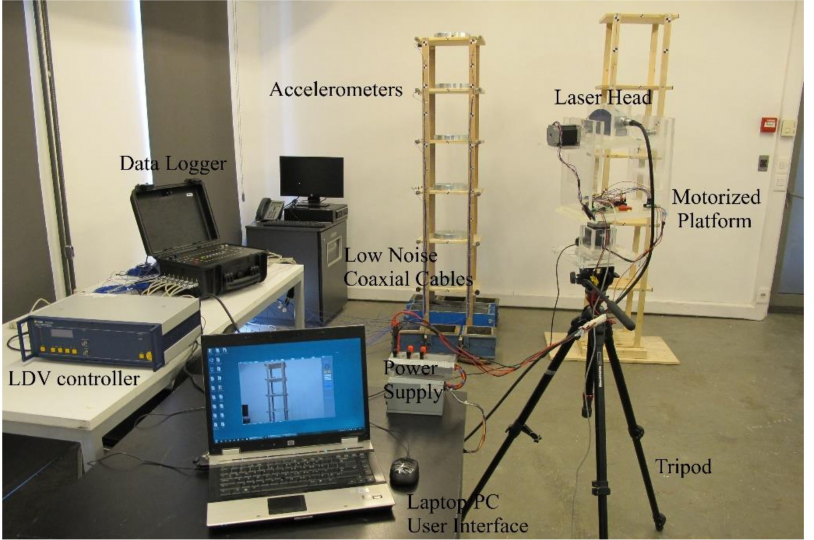
Figure 2. Main components of the measurement system.